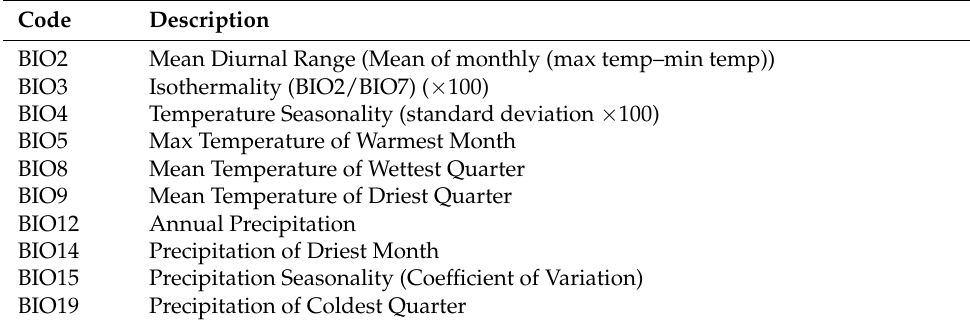
Table 1. Bioclimatic variables used in the ecological niche